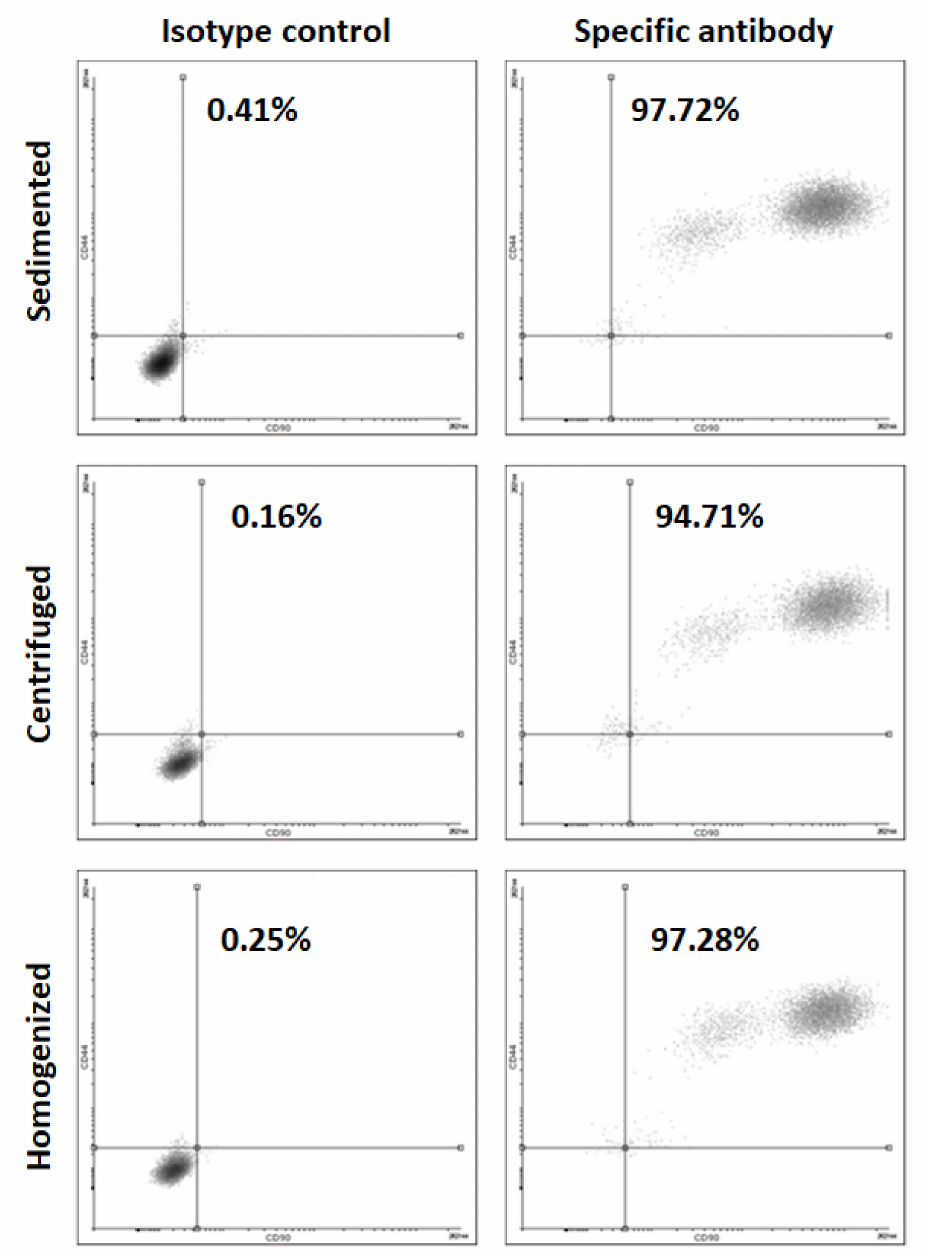
Figure 7. Flow cytometry for MSC marker CD 44 for the cells isolated from varying tissue